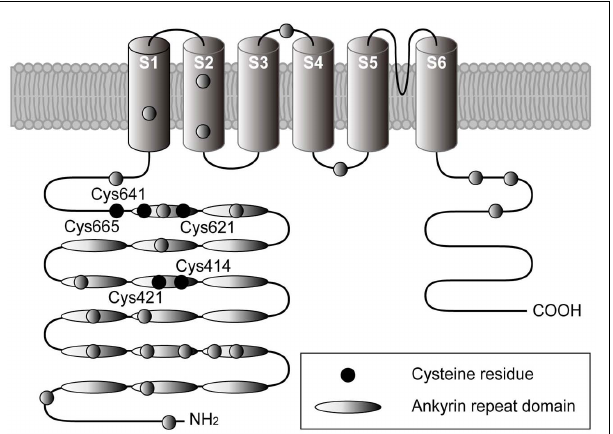
FIGURE 4 | Structural model forTRPA1 protein. Four identicalTRPA1 subunits are believed to be combined in the formation a functional channel. Each subunit spanning the plasma membrane six times (transmembrane domains S1–S6) has a long cytoplasmic N-terminal domain. Ovals indicate ankyrin repeats, while filled circles indicate cysteine residues identified as crucial sites for covalent modification ofTRPA1 (Hinman et al., 2006; Macpherson et al., 2007;Trevisani et al., 2007; Bessac et al., 2008; Maher et al., 2008;Takahashi et al., 2008;Taylor-Clark et al., 2009).